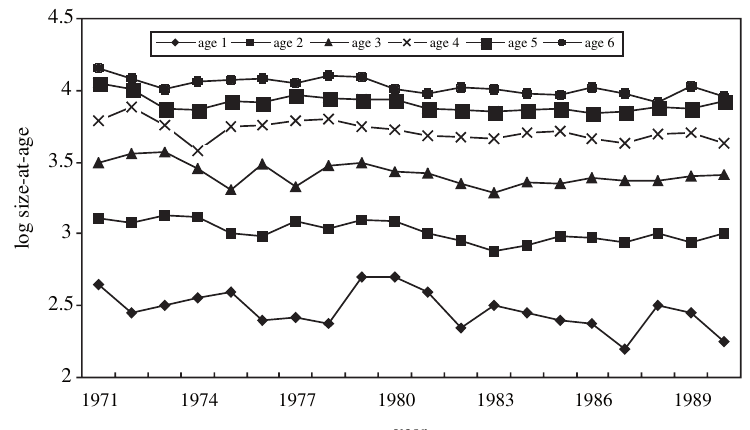
Fig . 1. – Variations in size (cm TL) of six age groups for the 1971 to 1990 year classes.